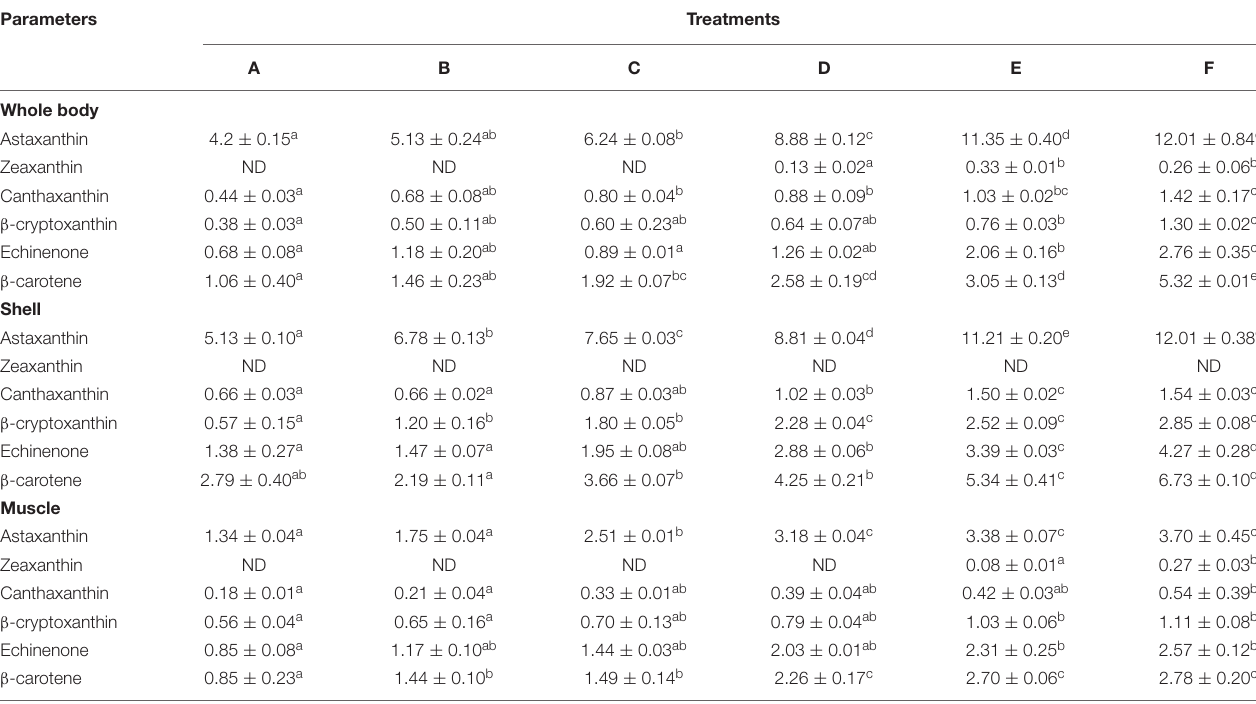
TABLE 5 | Carotenoid contents ( µ g/g) analysis in tissues of Penaeus monodon. #